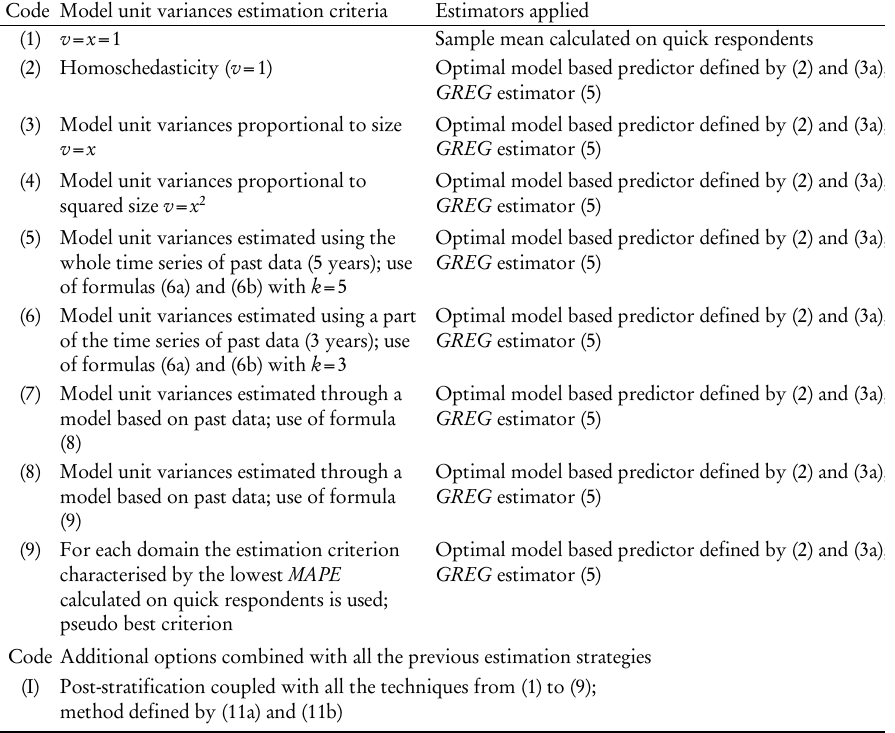
Estimation strategies tested and compared in the empirical attempt Code Model unit variances estimation